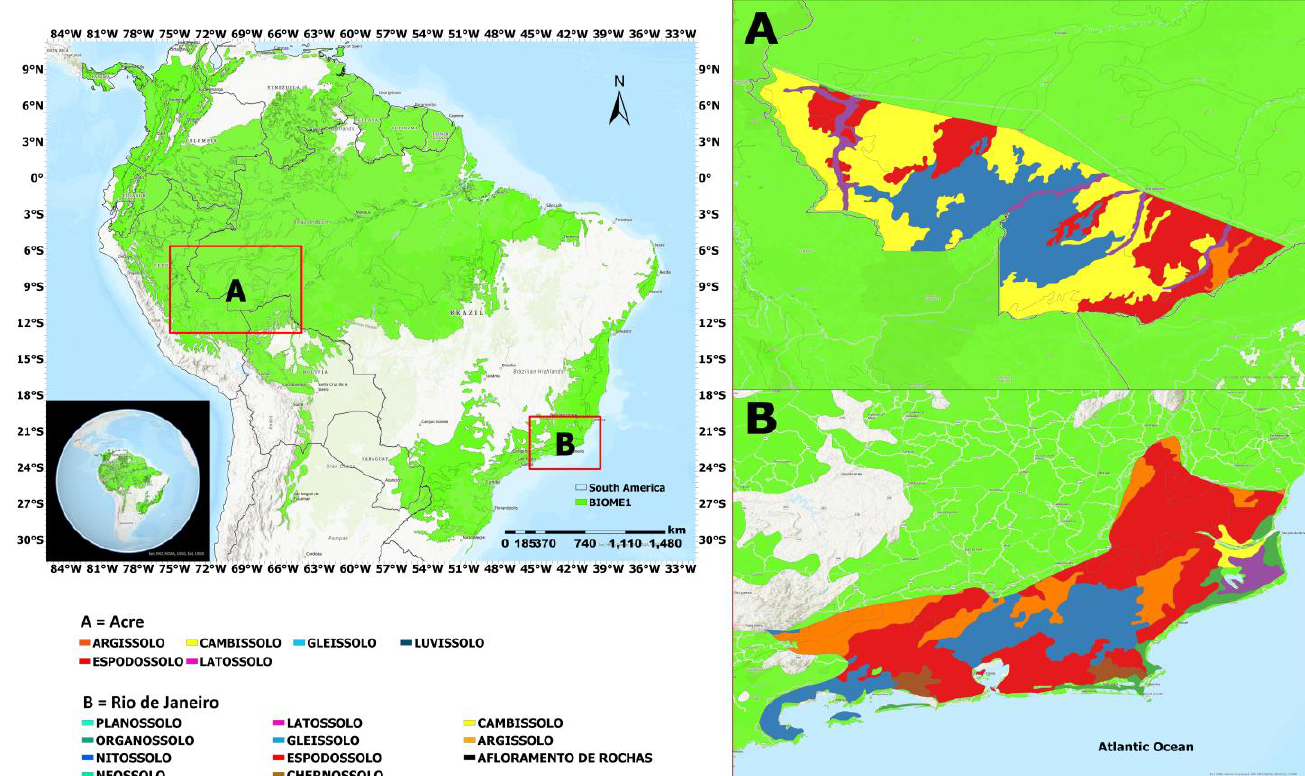
Figure 1. Coverage area and geographic location of Biome 1 in South America. ( A ) EAC and ( B ) ERJ with the predominant soil classification in these regions.